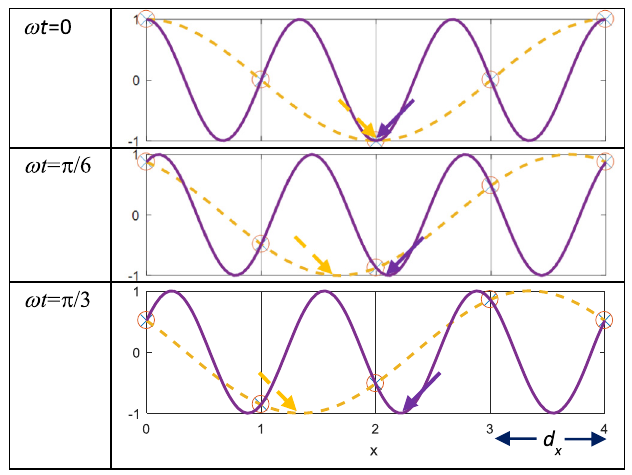
Fig. 3. The equivalence along cell boundaries of the phase in a negative medium (dashed curve moving leftward, n c = (cid:1) 1) and the phaseinapositivemedium(solidcurvemovingrightward, n 0 p ¼ 3 ). An arrow indicates an extremum for each wave at each time. See Supplementary Material for an animated version of this fi